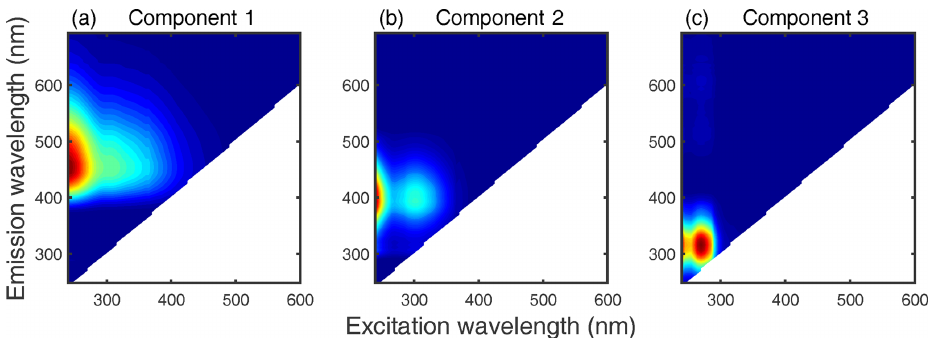
Figure 4. Fluorescent components identified by PARAFAC analysis. Table 2. Descriptions of fluorescent components identified by PARAFAC analysis. The secondary peaks are shown in